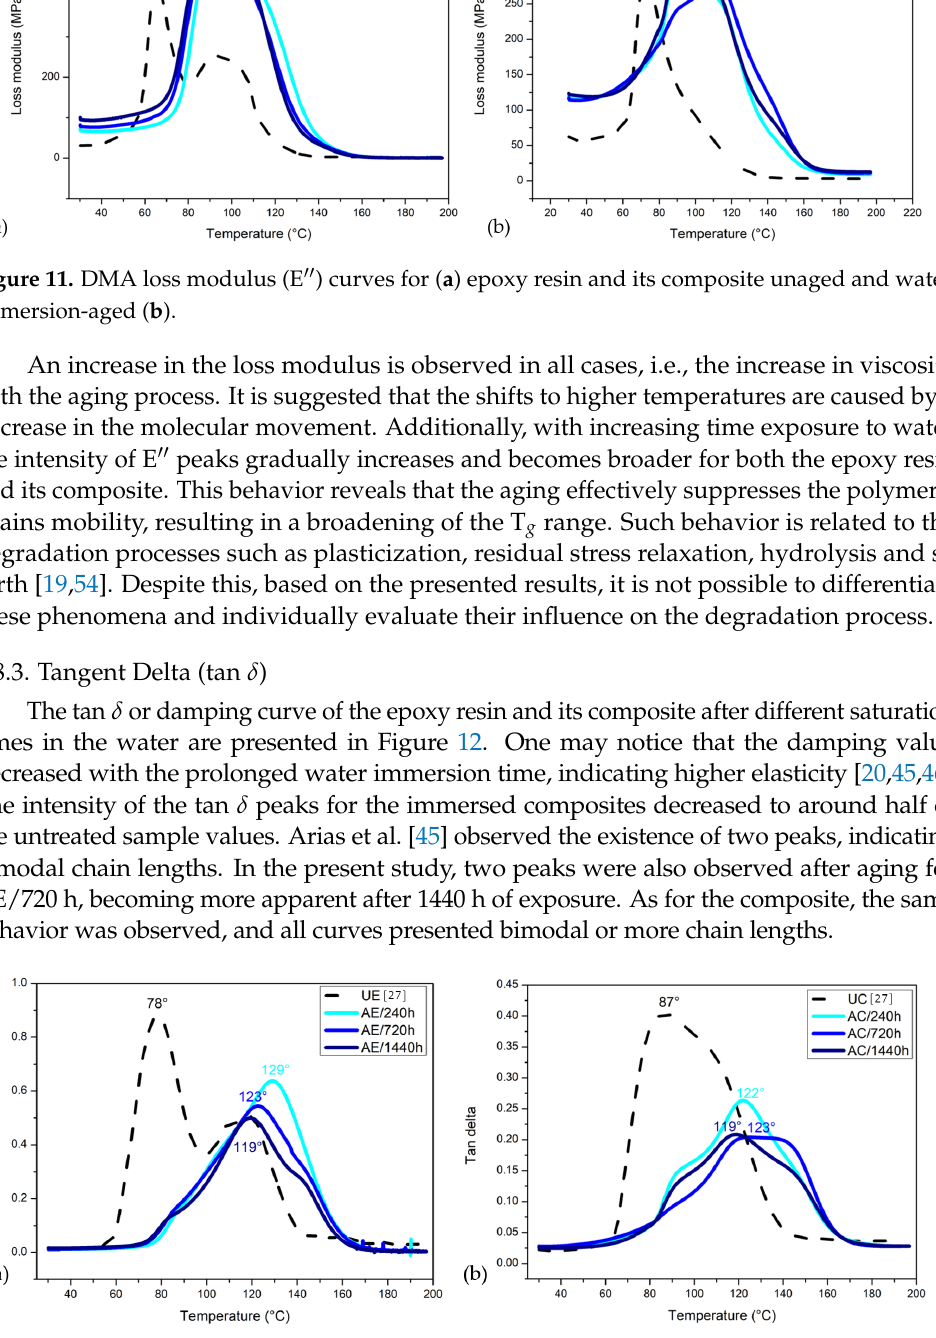
Figure 12. DMA tangent δ curves for ( a ) epoxy resin and its composite unaged and water-immersion- aged ( b